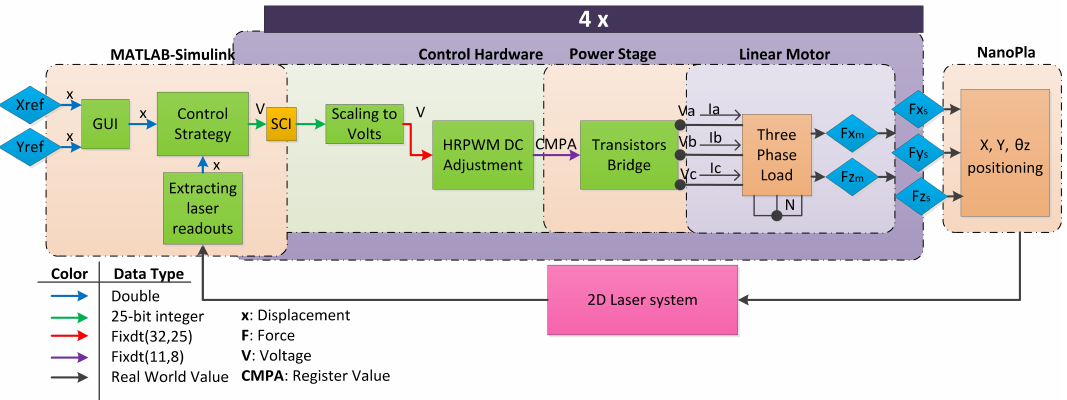
Figure 5. Scheme of the data flow in the NanoPla control